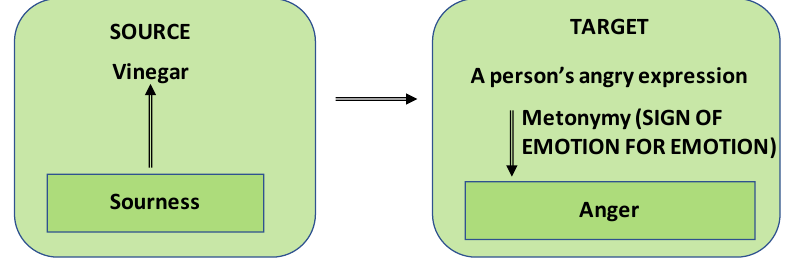
Figure 8. Metonymic reduction of the metaphoric target underlying the interpretation of estar hasta los huevos.